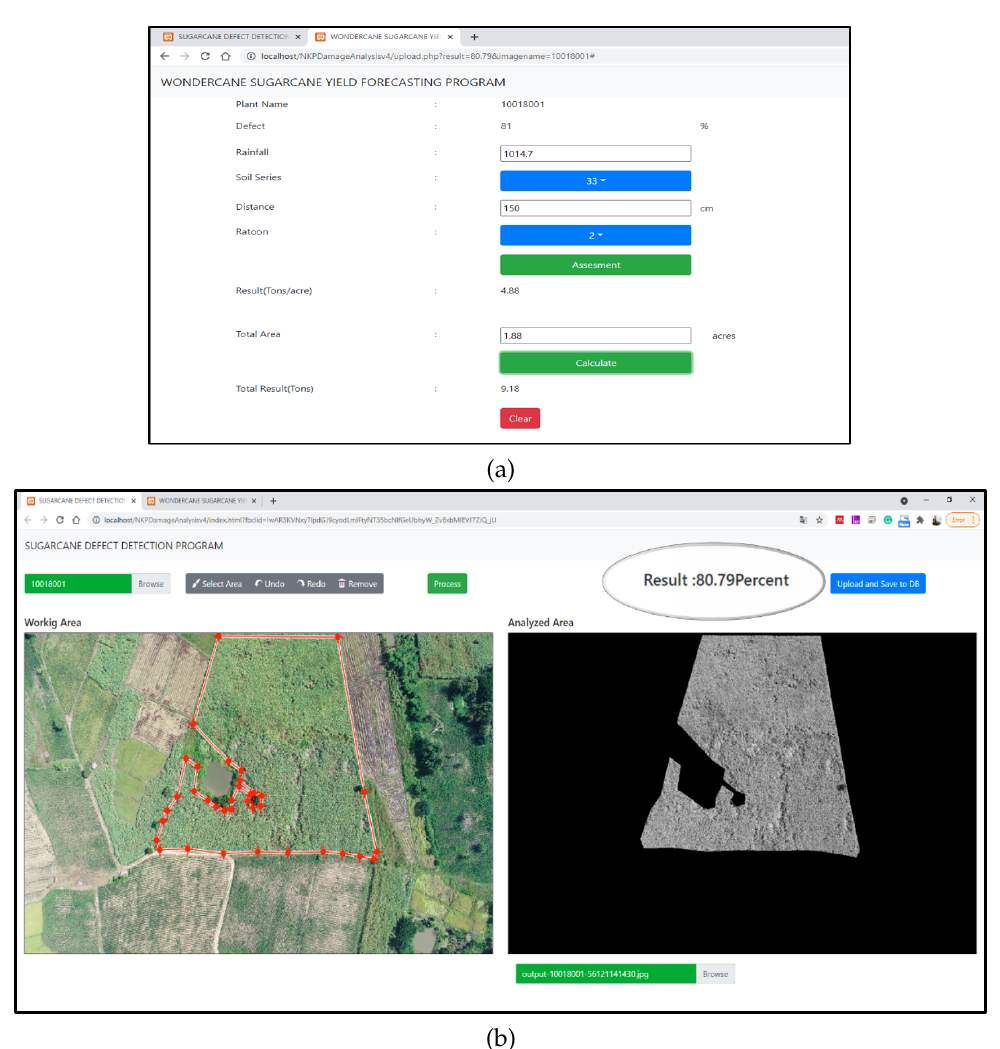
Figure 17. Sample screenshots of ( a ) the Wondercane sugarcane yield forecasting program working with ( b ) the sugarcane defect detection